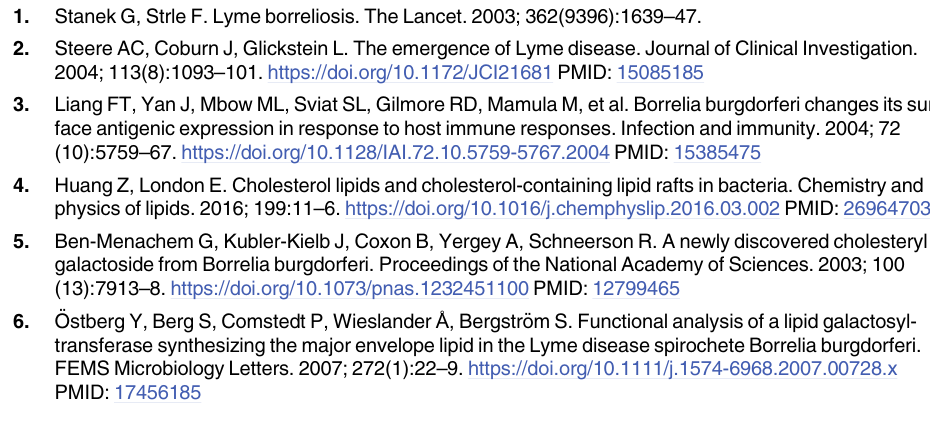
S1 Table. Selected Borrelia species for protein alignment and evolutionary analyses.